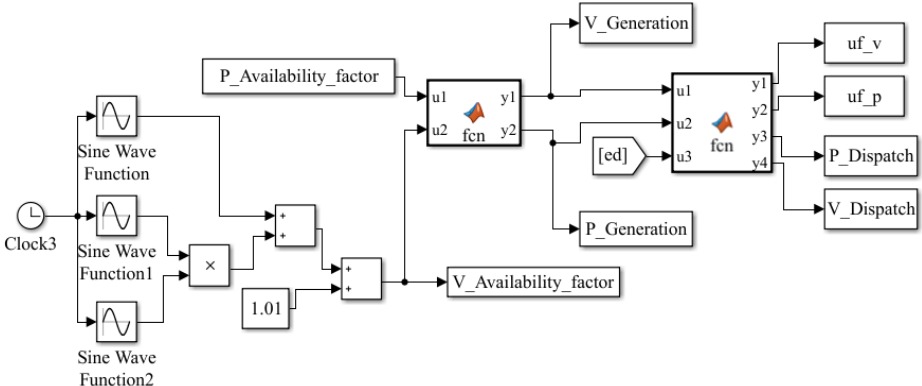
Figure A3. Electricity dispatch. Reprinted with the permission of Reference [13]. Copyright 2018 Elsevier.